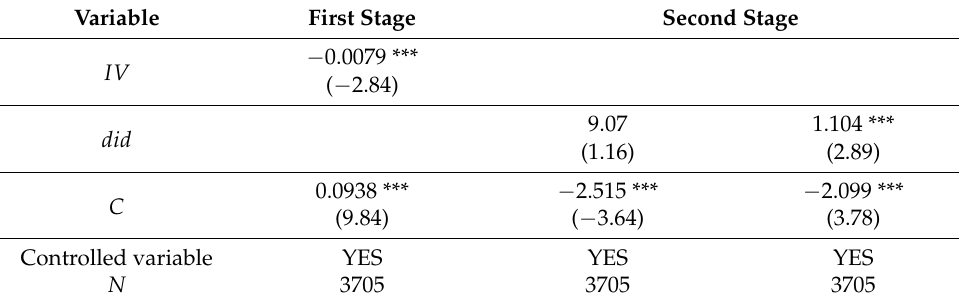
Table 6. Estimation results of models with instrumental